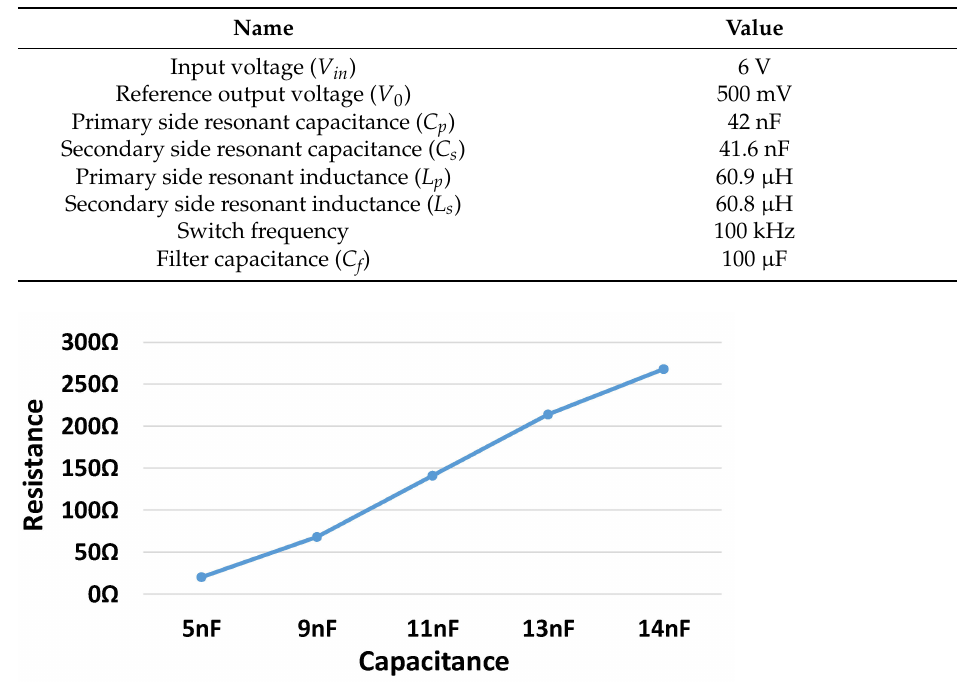
Table 6. Parameters in experimental circuit.